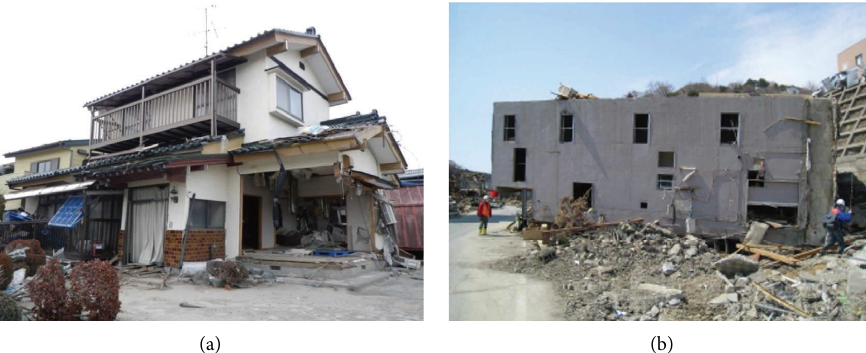
Figure 1: Damage of building. (a) An example of damage to a typical residential house in Japan. (b) An example of overturned building in Onagawa town. Te building had fewer openings and failure of the pile foundation was